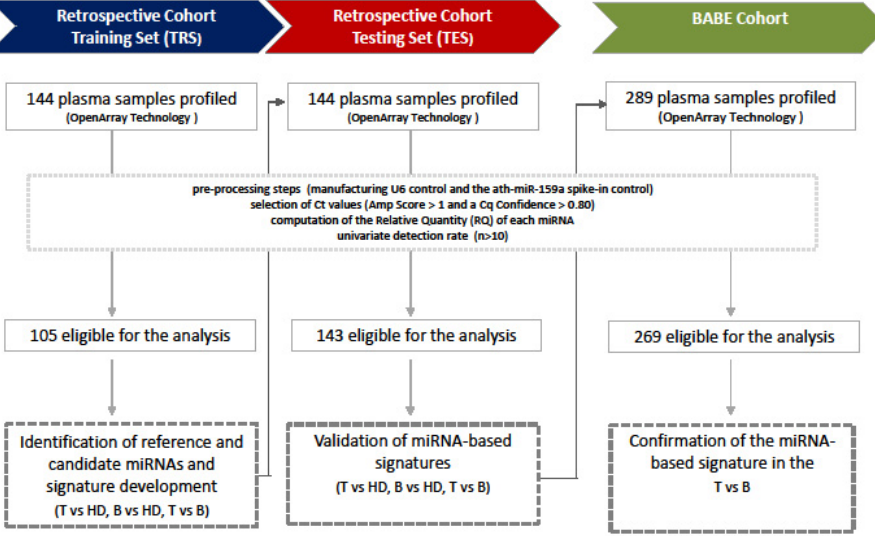
Figure 1. Study workflow. Graphical representation of plasma samples profiled and analyzed by OpenArray technology for each cohort.